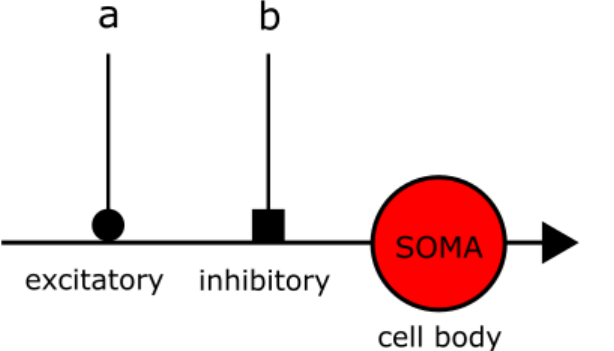
Figure 1. A basic model used for describing the nonlinear relationship between excitatory dendrites (a) and inhibitory dendrites